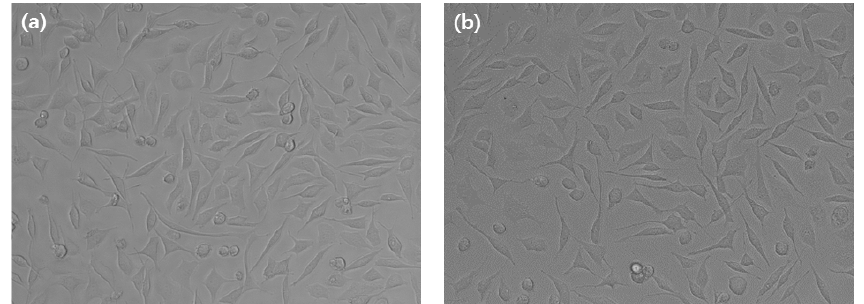
Figure 2. Paeonia lactiflora extract of cell morphology ( a ) control group ( b ) experimental group (200 μ g/mL).